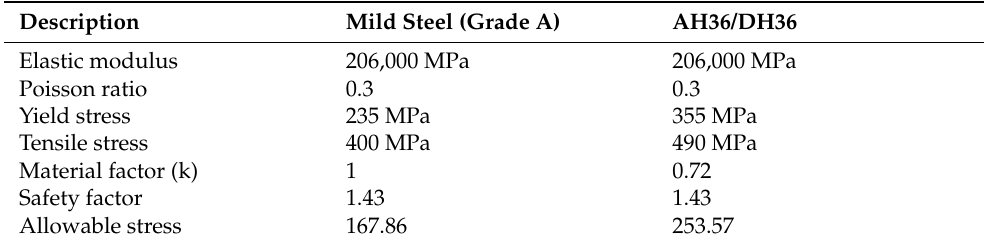
Table 7. Material properties of the plate